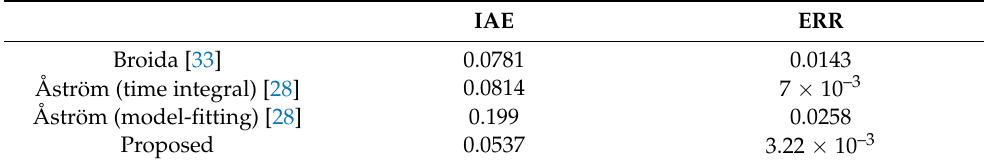
Figure 12. The Bode plots for process G P2 . Table 5. The criteria values for the process G P2 .